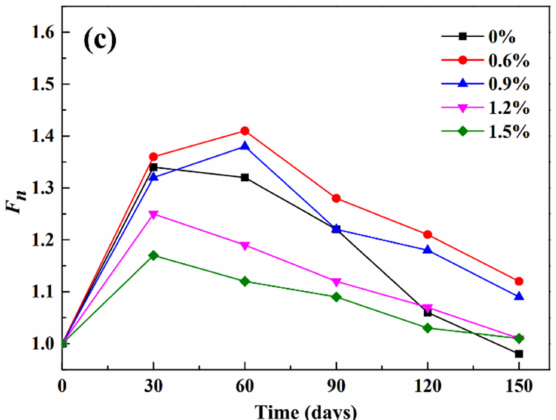
Figure 8. The corrosion resistance coefficient of flexural strength of the treated PP fiber mortar test specimens under different C/S ratios: ( a ) 1:1; ( b ) 1:1.5; ( c )